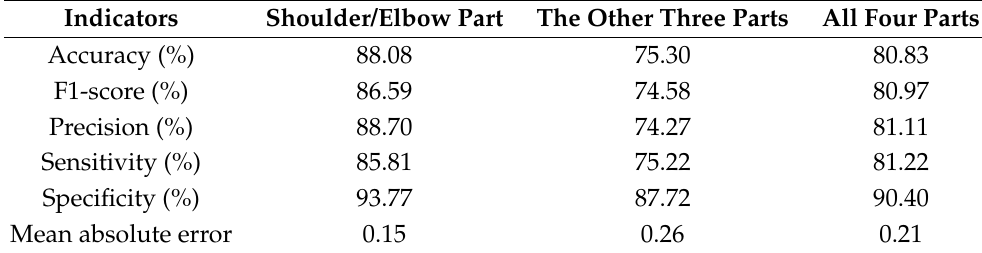
Figure 6. The results of single FMA items. ( A ) Prediction accuracy (%) and mean absolute error (MAE) (points) of each automated FMA item, where the red part denotes the items of the Shoulder/Elbow category scored by random forest classification, and the blue part denotes those of the other three parts scored by rule-based logic methods. The bar graph is the accuracy, while the line graph is the MAE. ( B ) A confusion matrix showing single item scores assigned by a therapist versus estimated by the automated system, with 600 items in total (30 items for each of 20 subjects). Table 5. Average results of performance metrics for single